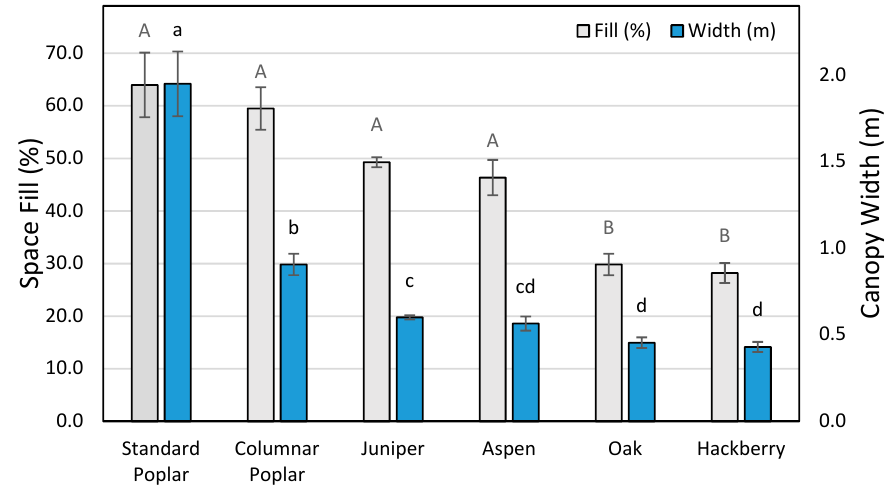
Figure 2. The average width and space of candidate windbreak species. Space fill (%) is shown on the left, and average tree width is shown on the right. Standard poplar showed the greatest ability to produce horizontal growth and the greatest percentage of space filled. Hackberry and oak both showed the least amount of horizontal growth and ability to fill the allotted